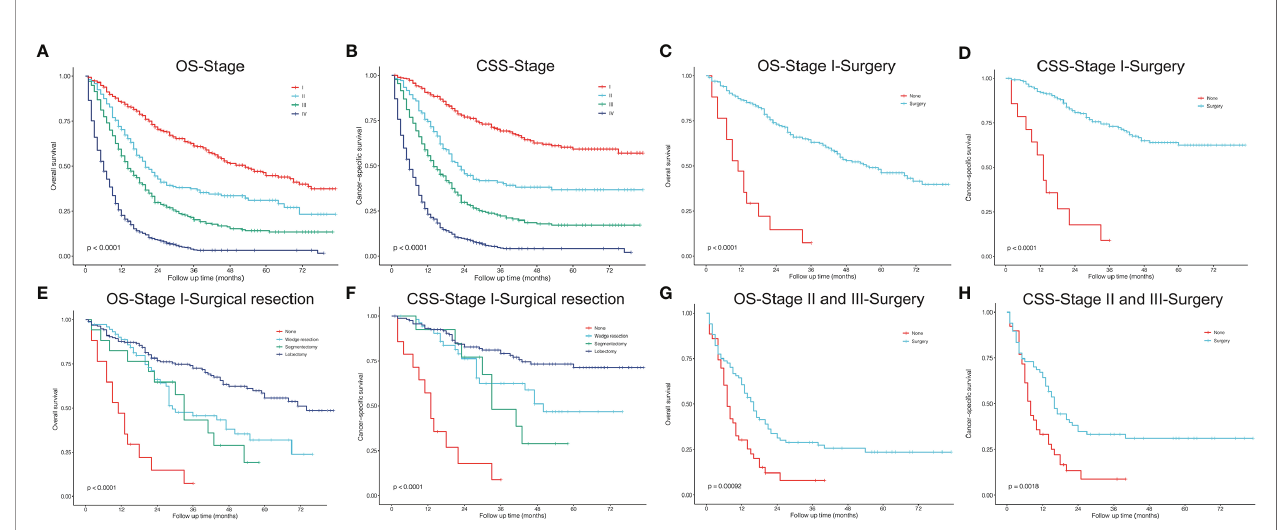
FIGURE 5 | Kaplan – Meier curves. (A, B) Stage, AJCC 7th edition; (C, D) stage I, surgery vs . no surgery; (E, F) stage I, surgical resections; (G, H) stage II and III, surgery vs . no surgery. OS, overall survival; CSS, cancer-speci fi c